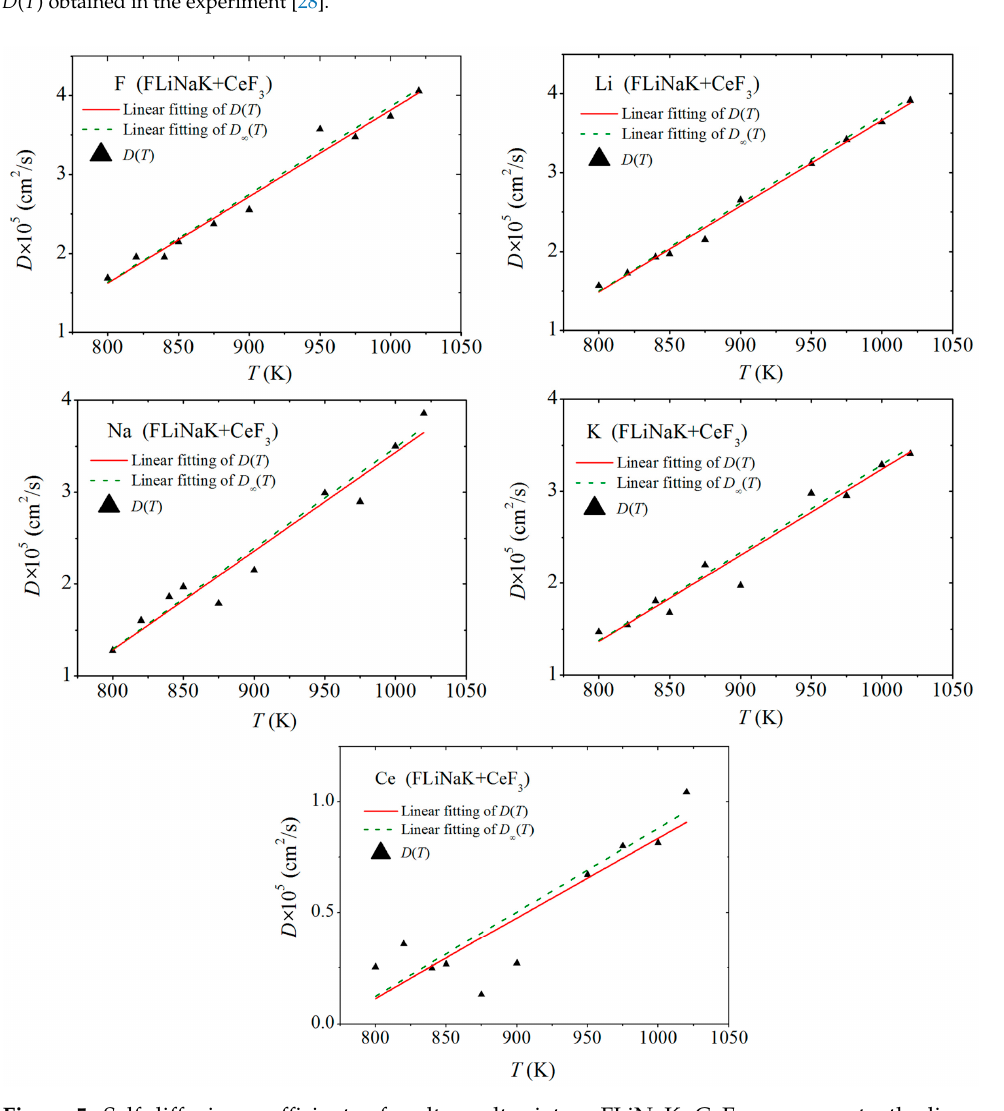
Figure 5. Self-diffusion coefficients of molten salt mixture FLiNaK+CeF 3 components; the linear approximation of the MD calculation of the D coefficient is presented as a solid line, and the linear approximation of the D ∞ ( T ) dependence is shown as a dashed